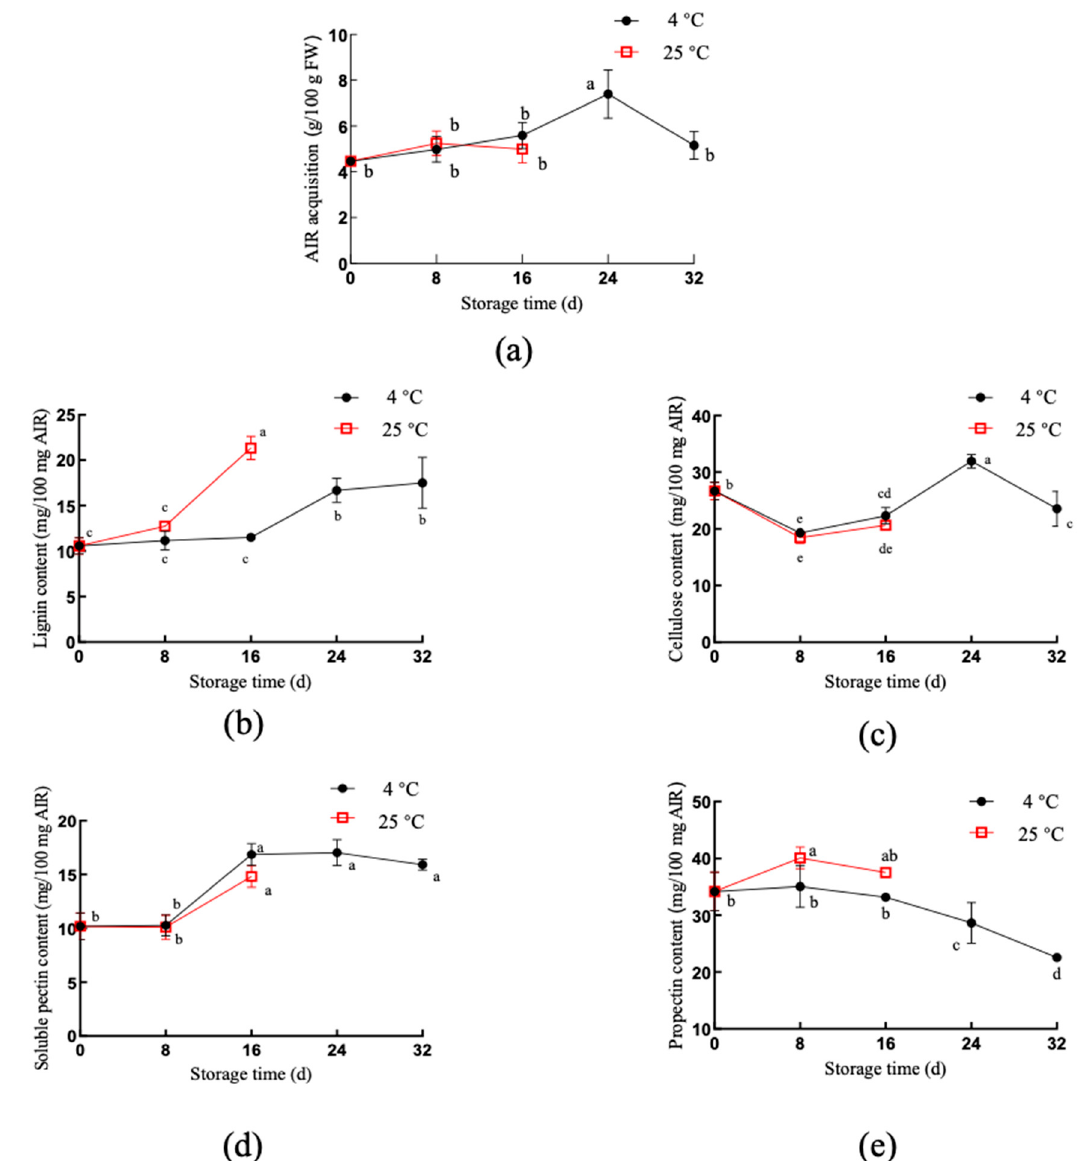
Figure 3. Changes of cell wall polysaccharide composition in Z. latifolia during storage at different temperatures. ( a ) Alcohol insoluble matter (AIR), ( b ) lignin content (LIG), ( c ) cellulose content (CEL), ( d ) soluble pectin content (SPC), and ( e ) propectin content (PROP) were measured from samples stored at either 4 ° C or 25 ° C. Each value was expressed as mean ± standard error ( n = 3). Different letters indicate a significant difference between the different storage times ( p < 0.01).